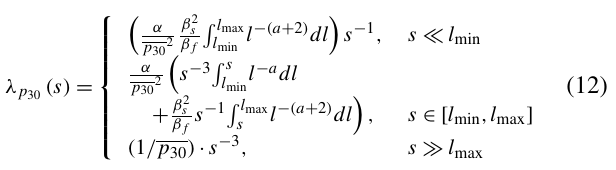
2 + σ 2 ((cid:53)(l,s)) and